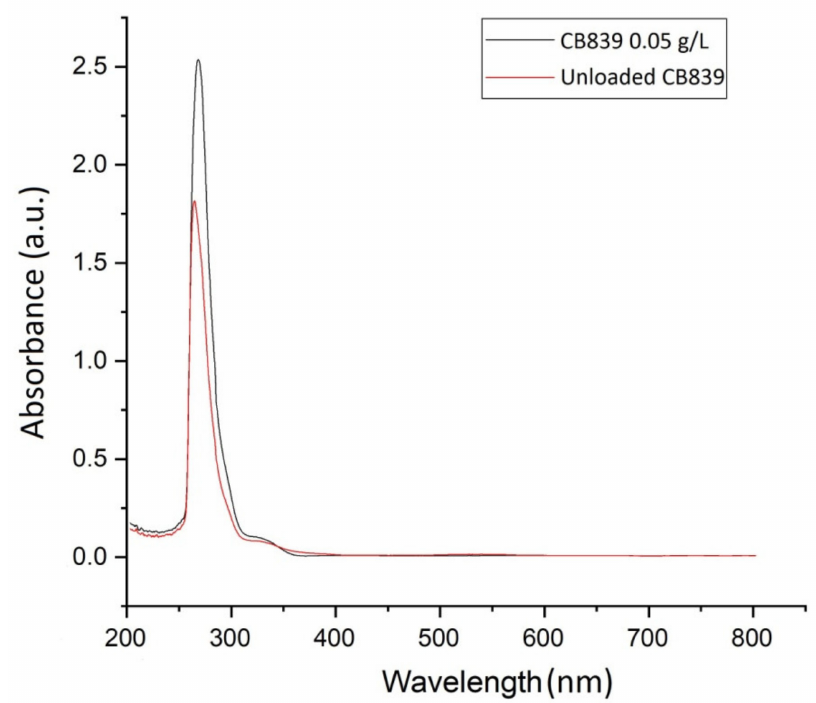
Figure 5. Comparison of absorbance standard concentration of CB-839 (0.05 g/L) with unloaded CB-839 in the supernatant. The percent of drug loading efficiency was calculated by the formula based on λ max of absorbance, which was approximately